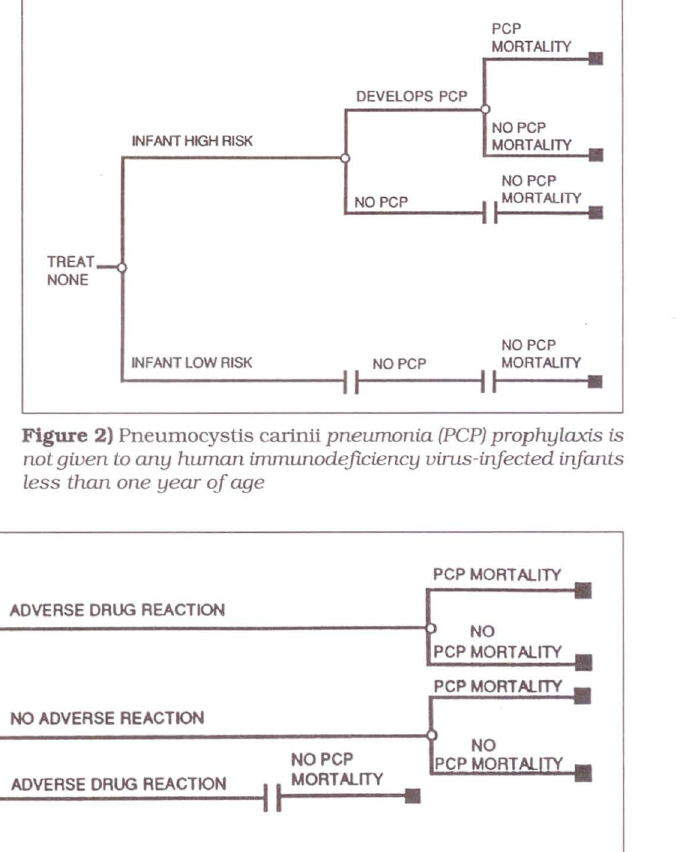
Figure 3) Hwnan immunodeficiency virus-infected infants less than one year of age who have baseline CD4 counts fewer than 1500 cells/ mm 3 receive Pneumocystis carinii pnewnonia (PCP) prophylaxis. Infants with CD4 counts equal to or greater than 1500 cells/ mm